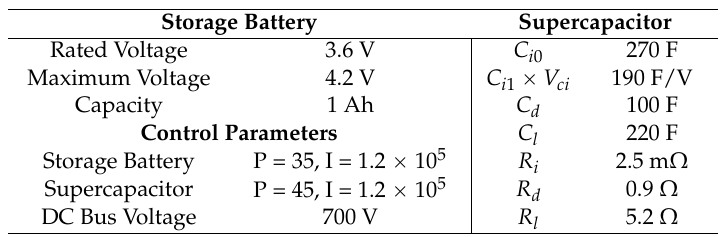
Table 1. Battery and supercapacitor simulation parameters.